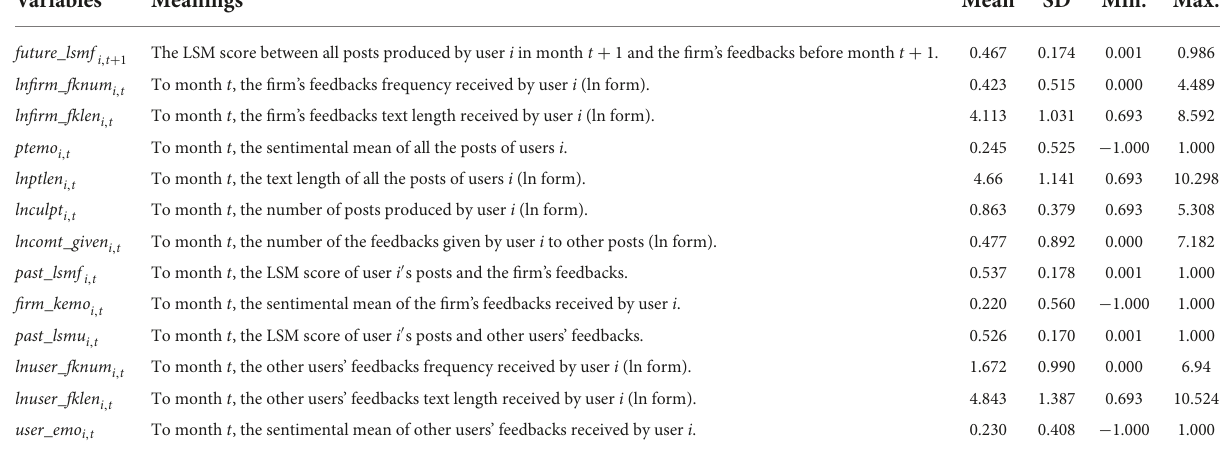
TABLE 2 Regression